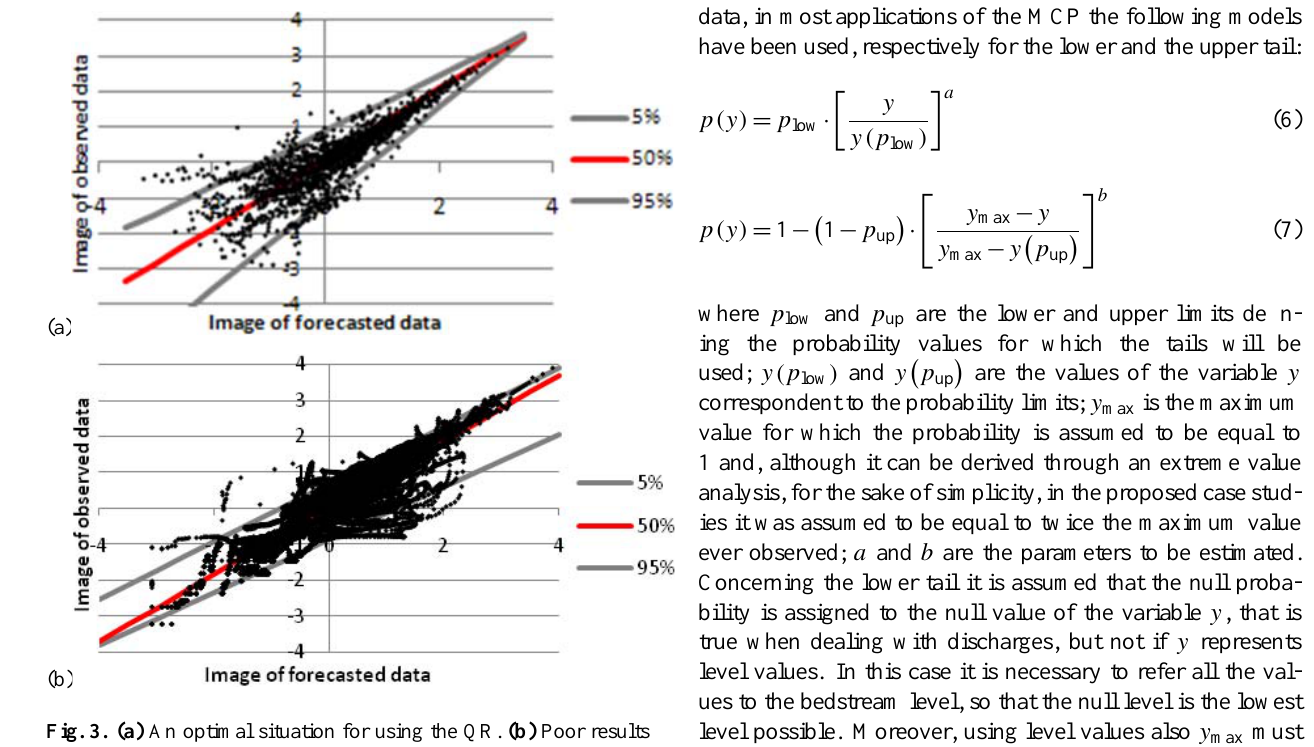
Fig. 3. (a) An optimal situation for using the QR. (b) Poor results are obtained using QR in the situation represented here, which, by the way, is quite common in hydrological